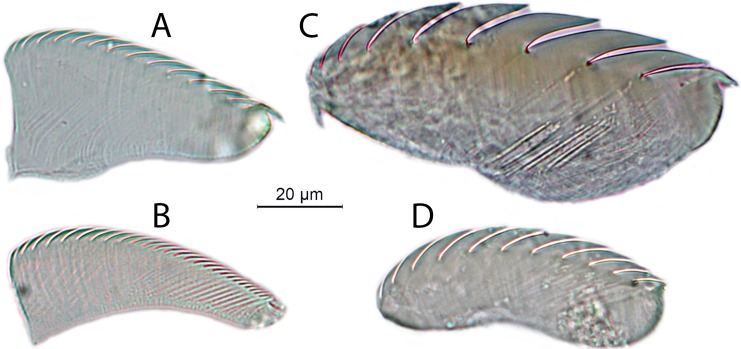
 Uncini from ventral neuropodial tori of region C.Chaetopterus cf. appendiculatus: (A) upper tori; (B) lower tori. Chaetopterus sp.: (C) upper tori; (D) lower tori.